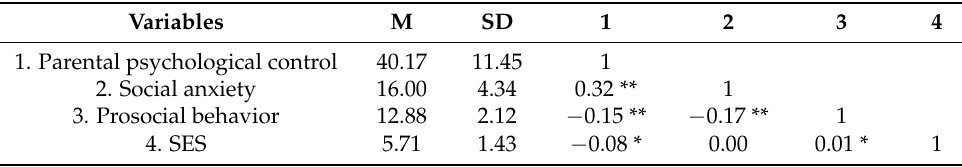
Table 1. Results of descriptive statistical